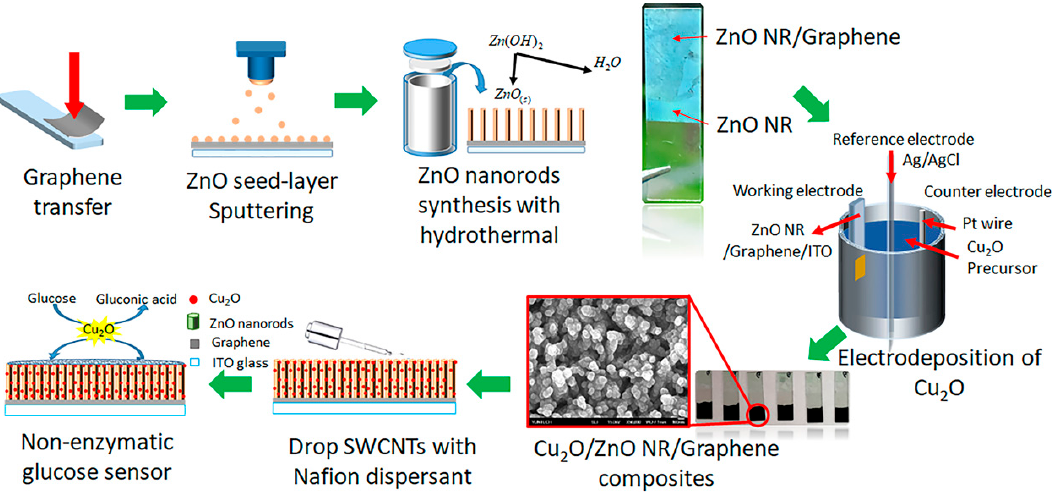
Figure 1. Synthesis steps of single-walled carbon nanotubes (SWCNTs)/Cu 2 O/ZnO NRs/graphene hybrid electrodes, including graphene transfer, ZnO NR synthesis with hydrothermal, Cu 2 O growth with electrodeposition, and drop SWCNTs with Nafion dispersant for nonenzymatic glucose sensors. Reproducedfrom Chen, H.C.; Su, W.R. and Yeh, Y.C., 2020. Functional channel of SWCNTs/Cu 2 O/ZnO NRs/graphene hybrid electrodes for highly sensitive nonenzymatic glucose